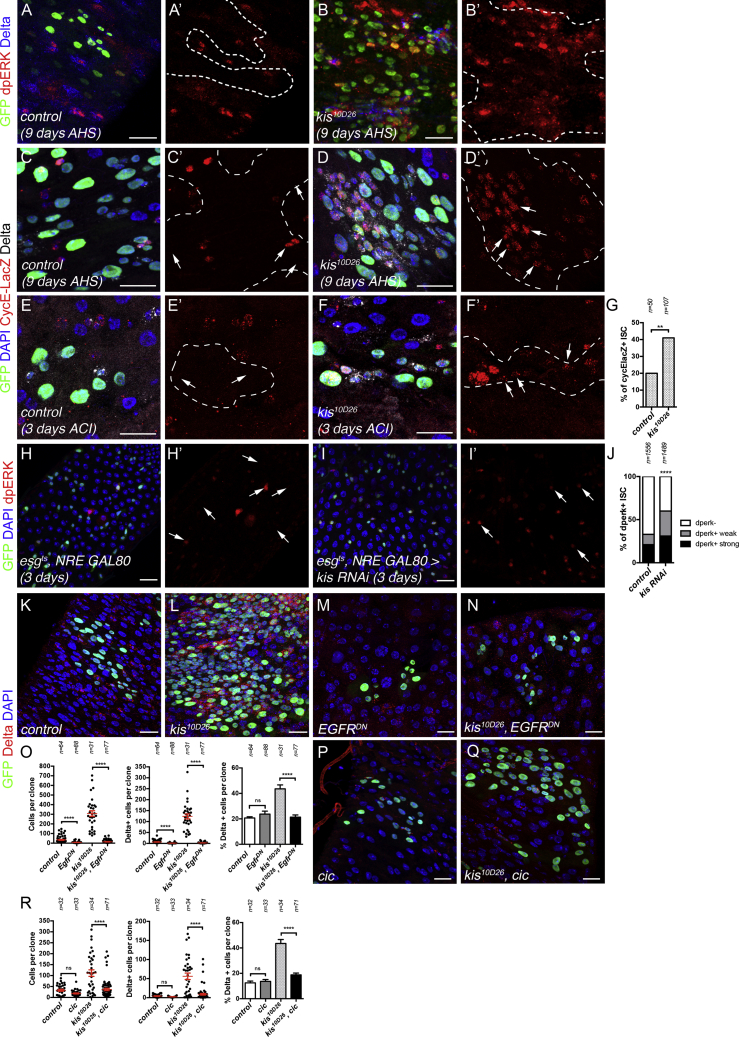
Kismet Controls Proliferation by Regulating EGFR Pathway Activity(A–D′) Wild-type (A, A′, C, and C′) and kis10D26 (B, B′, D, and D′), 9 days AHS MARCM clones. EGFR signaling, detected by dpERK (A–B′) and EGFR target CycE-LacZ (C–D′), was increased in kis10D26 clones.(E–F′) Wild-type (E and E′), and kis10D26 (F and F′), 3 days AHS MARCM clones expressing CycE-LacZ.(G) Proportion of ISCs expressing CycE-lacZ from (E) and (F′).(H and I) ISC-specific expression of GFP (H) or kis RNAi (BL34908) (I), 3 days at 29°C.(J) Quantification of proportion of ISCs showing strong, weak, or no dpERK from (H)–(I′).(K–N) 12-day AHS clones: wild-type (K), kis10D26 mutant (L), expressing UAS-EGFRDN (M), and kis10D26 mutant expressing UAS-EGFRDN (N).(O) Clone size, number of Delta+ cells/clone, and % of Delta+ cells/clone from (K)–(N).(P and Q) 10-day AHS clones: wild-type expressing cic (P) and kis10D26 mutant expressing cic (Q).(R) Clone size, number of Delta+ cells/clone, and % of Delta+ cells/clone from (P) and (Q).Results compared using a chi-square test in (G) and (J) and a two-tailed Mann-Whitney test in (O) and (R). Mean values in red; error bars, SEM; ns = non-significant, **p < 0.01, ****p > 0.0001. Arrows highlight ISCs. Scale bars, 20 μm.